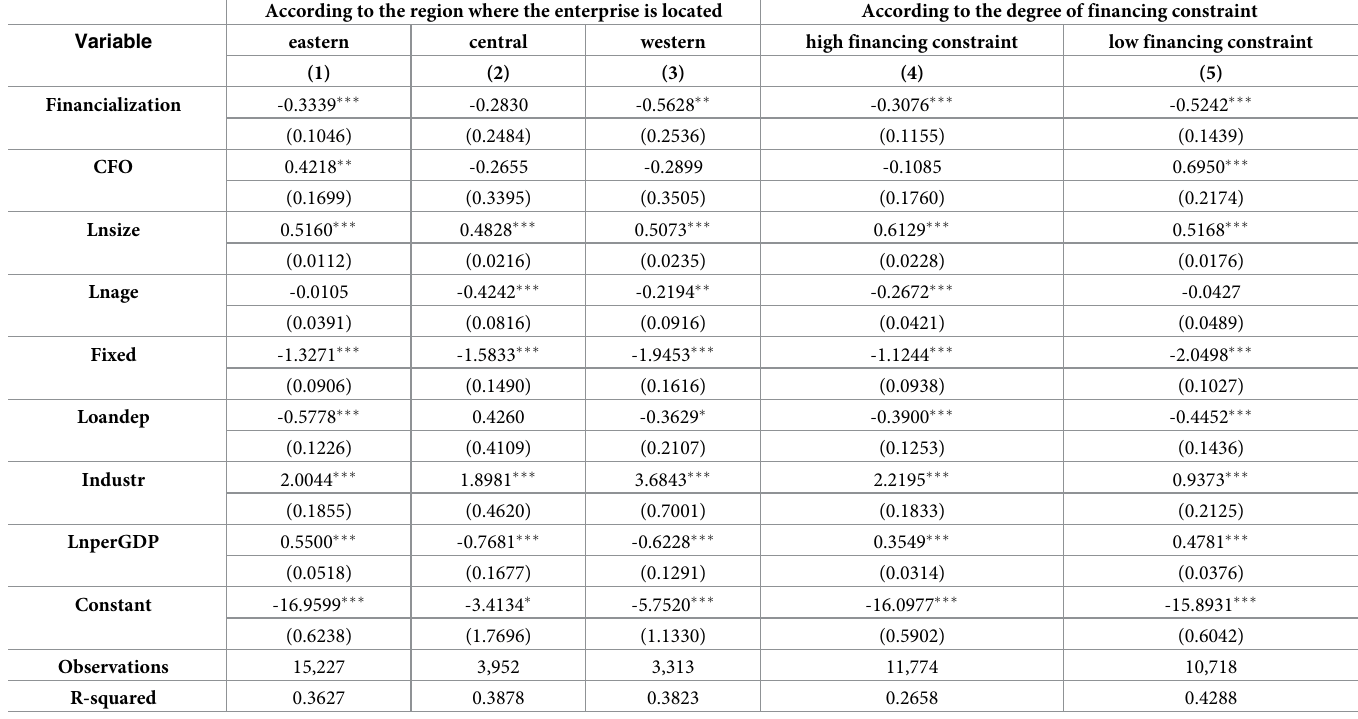
Table 7. Test results of the impact of enterprise financialization on technological innovation based on the external environment. According to the region where the enterprise is